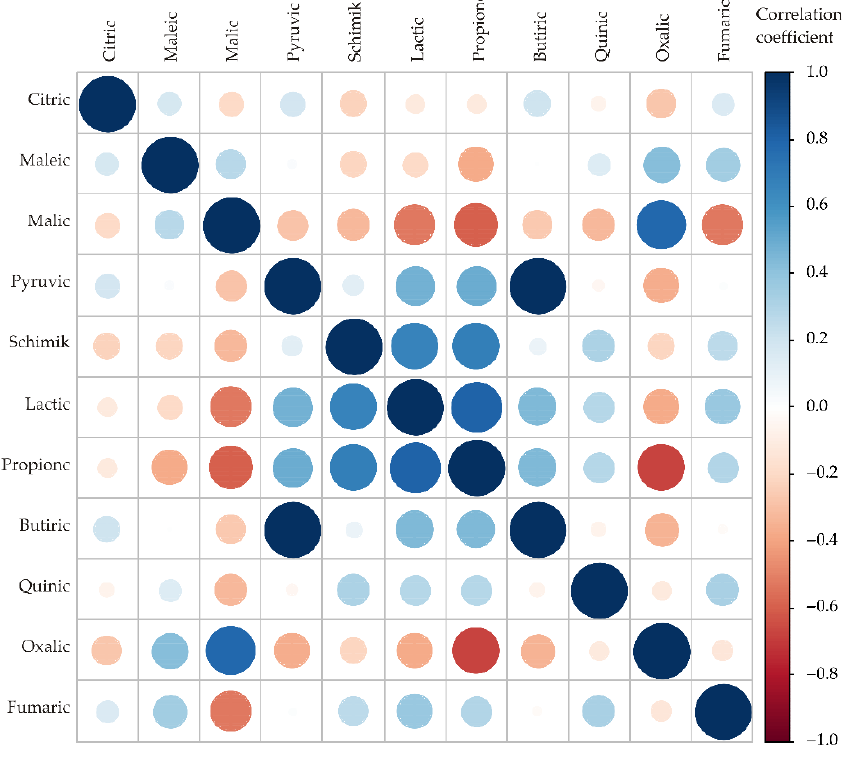
Figure A4. Color correlation graph between sugar contents in raspberry extract samples.